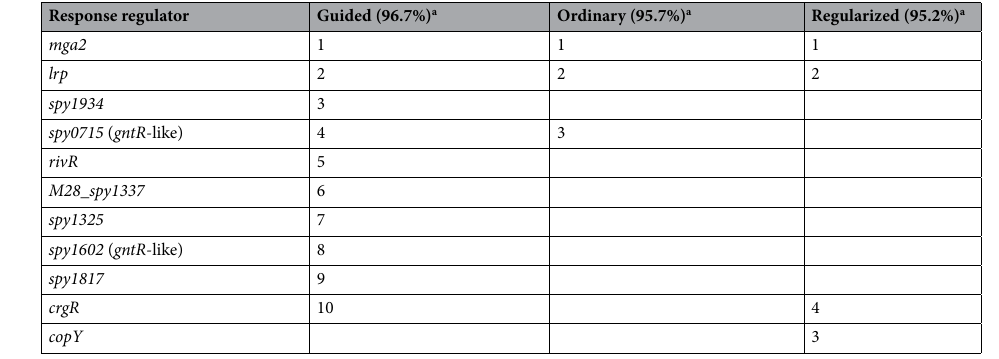
Table 2. Importance value rankings of response regulators alleles (predictor features) in the optimal feature sets inferring GAS emm -type for the random forest algorithms tested. The optimal feature set is the set of features (from 53 response regulator alleles) selected in attaining the highest accuracy of inferring the emm - type for a particular random forest algorithm. a The percentage in brackets is the accuracy of